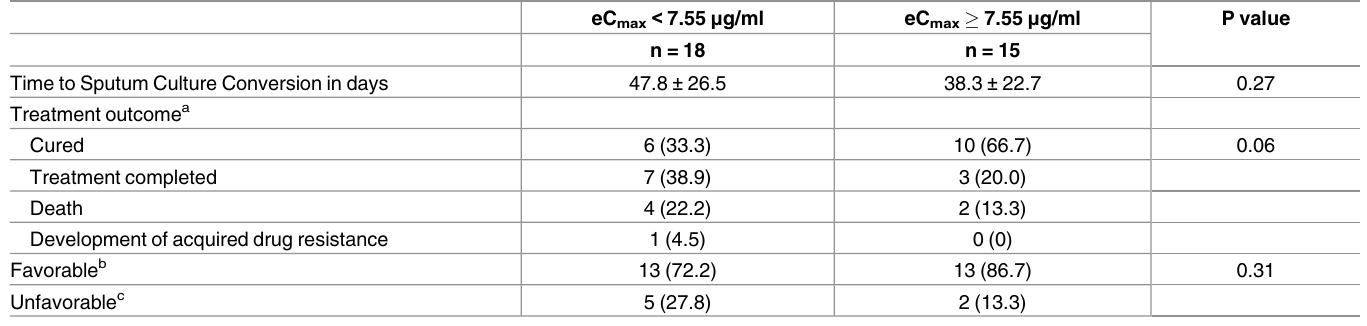
Table 3. CART derived eC max and